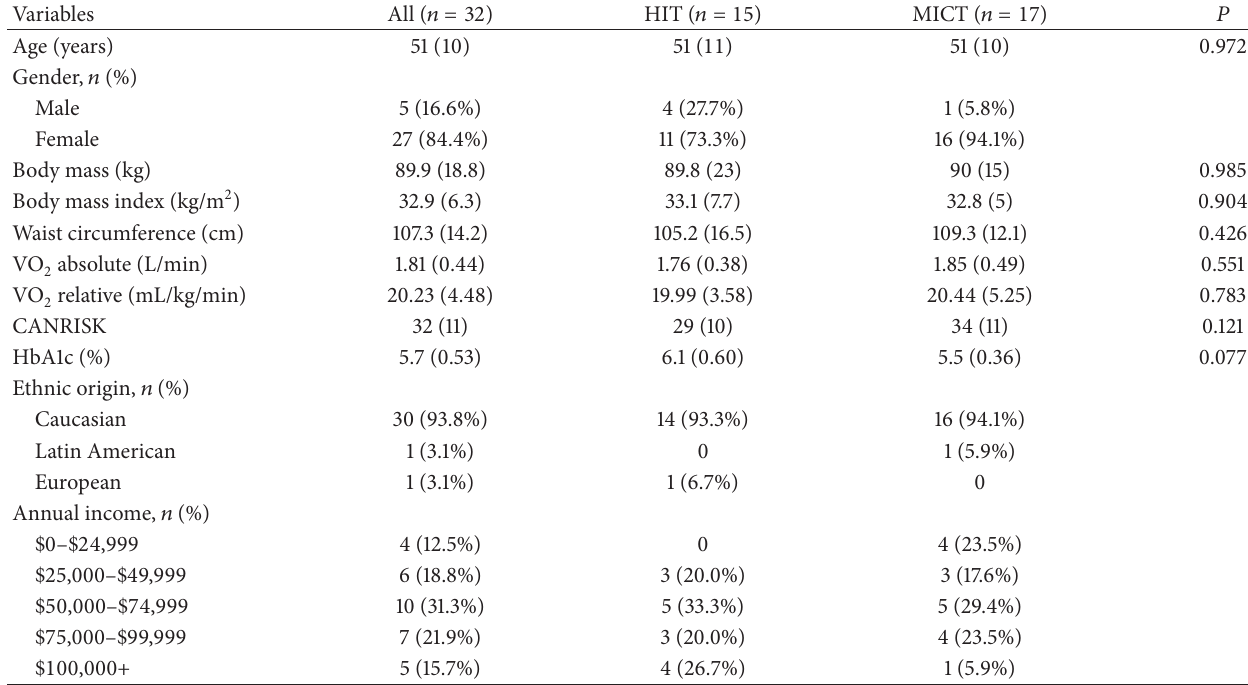
Table 1: Baseline characteristics of study participants randomized to high-intensity interval training (HIIT, n = 15) and moderate-intensity continuous exercise (MICT, n = 17) and comparisons between conditions.